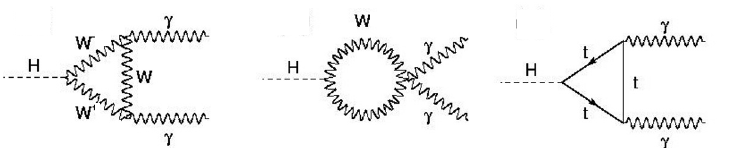
Figure 2 . The SM coupling of the Higgs to γγ .